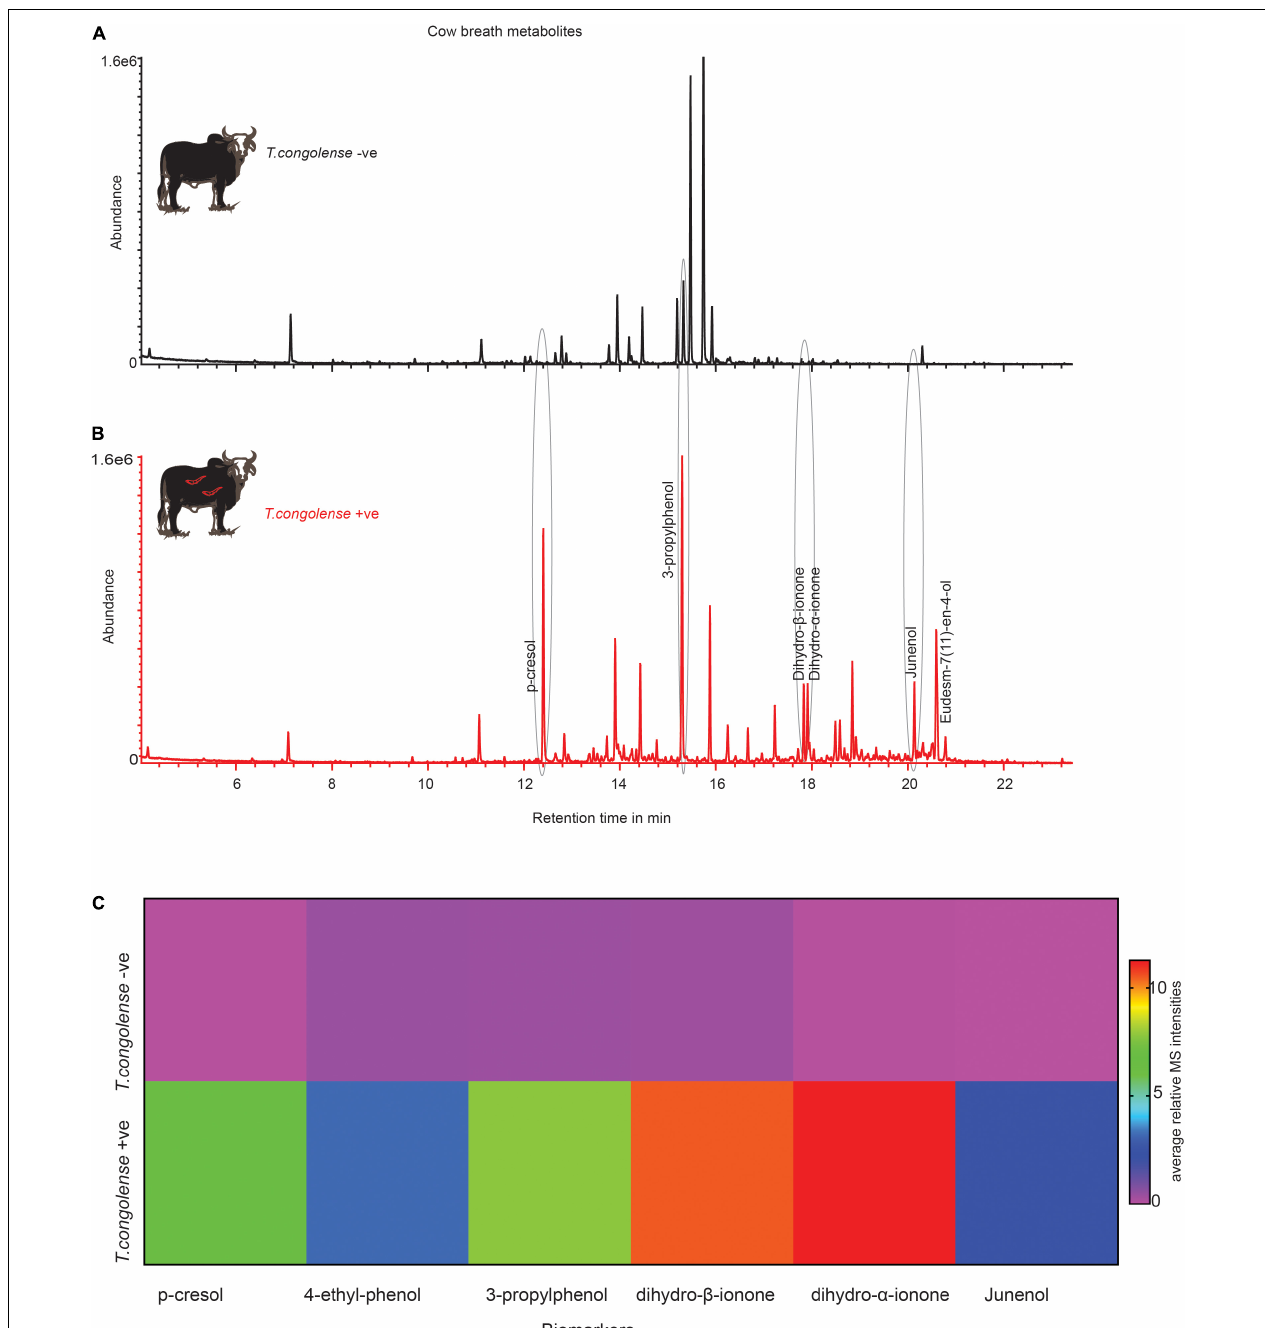
FIGURE 7 | Trypanosoma congolense infection induced similar metabolites in cow breath. (A) Representative GC-MS trace showing the breath odor components of healthy cow. (B) T. congolense -infected cow breath. (C) The heat map based on the mean relative MS intensities of breath metabolites induced due to T. congolense infection, n =